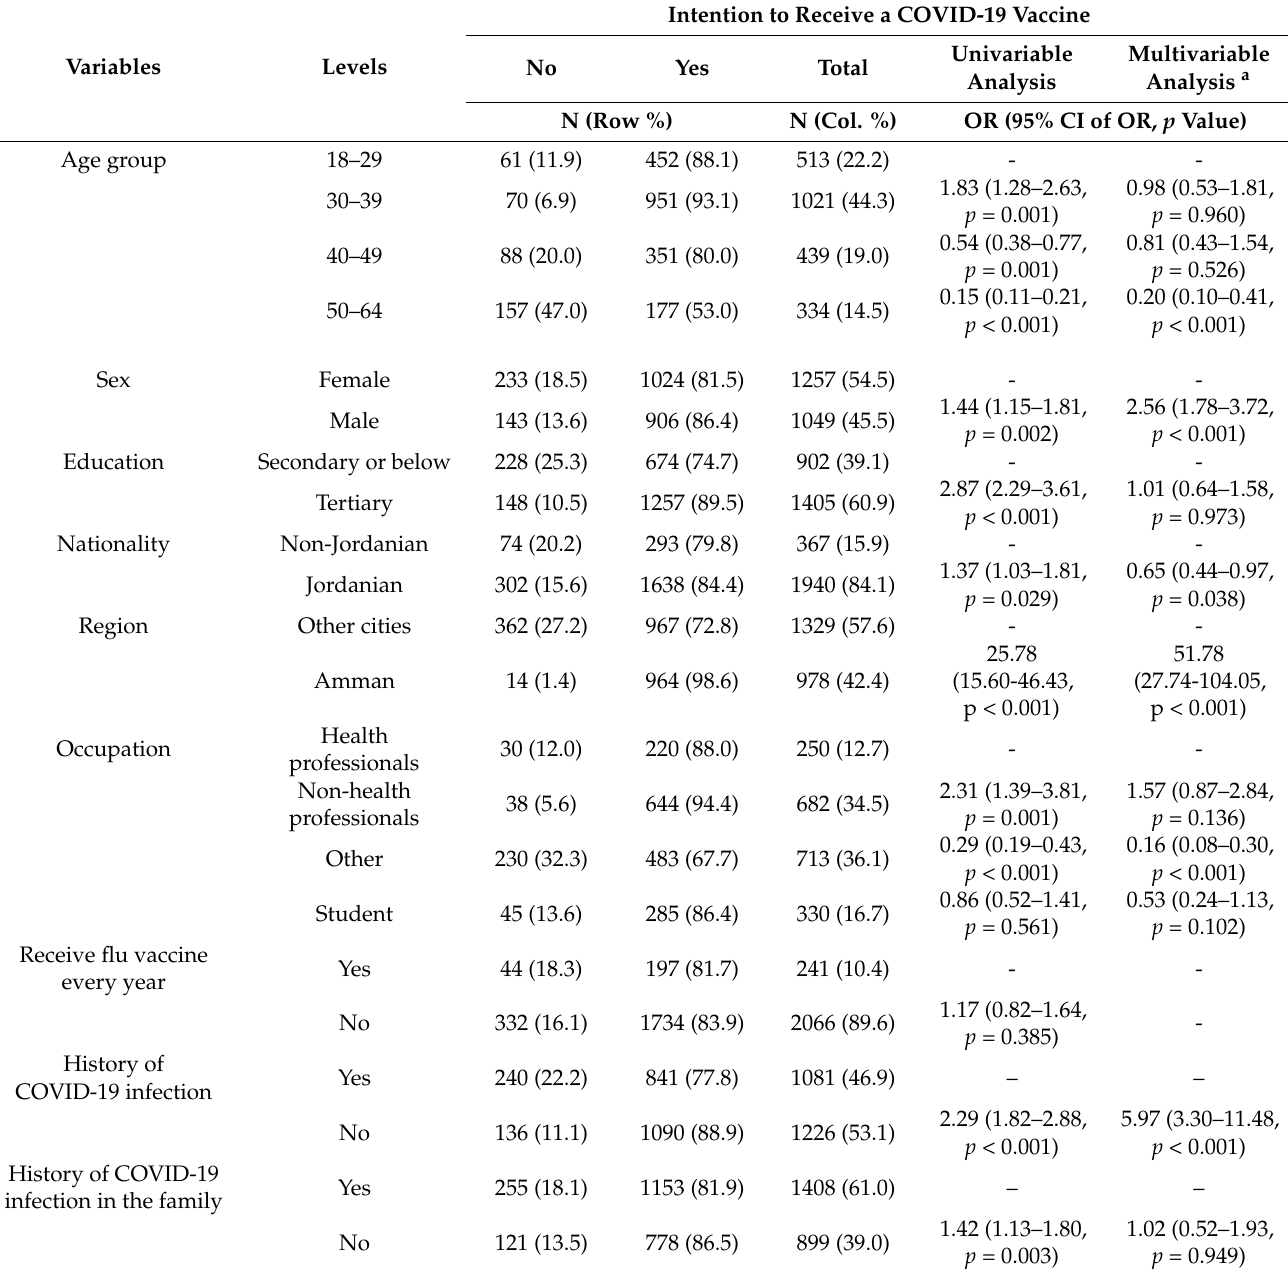
Table 1. Socio-demographic factors associated with the intention to receive a COVID-19 vaccine in